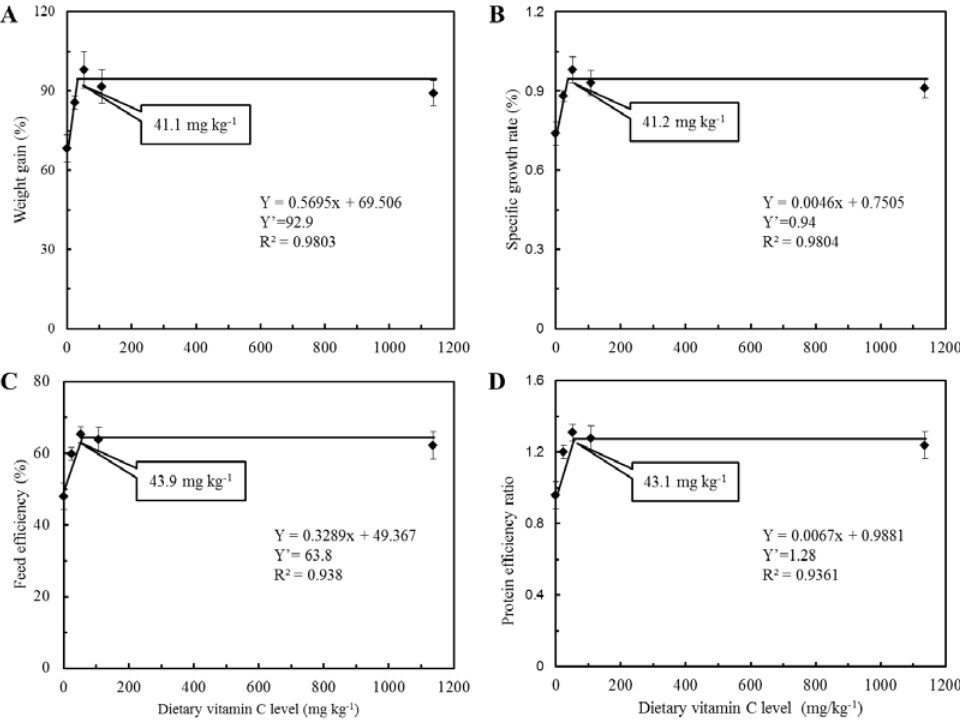
Figure 1. Broken-line analysis of (a) weight gain (WG), (b) specific growth rate (SGR), (c) feed efficiency (FE) and (d) protein efficiency ratio (PER) of juvenile eels fed diets containing different levels of vitamin C for 12 weeks. Values on the X-axis are the vitamin C levels in experimental diets. Values are means ± SD of 3